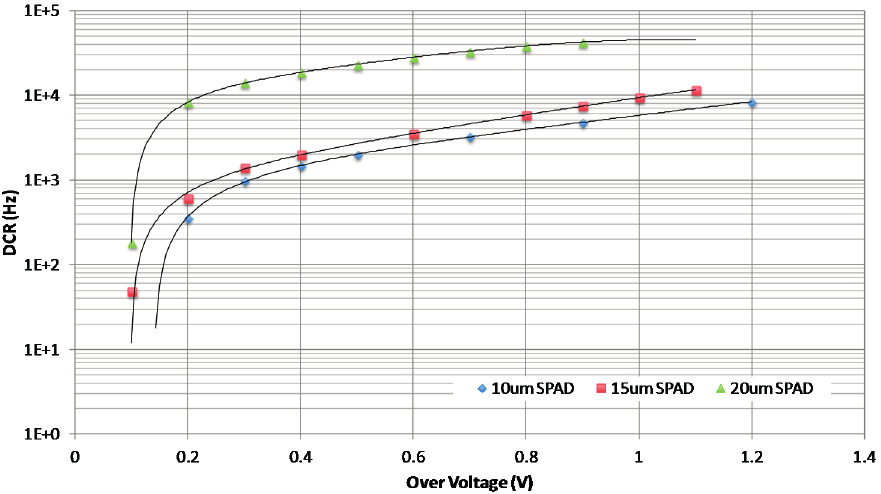
Figure 5. DCR as a function of